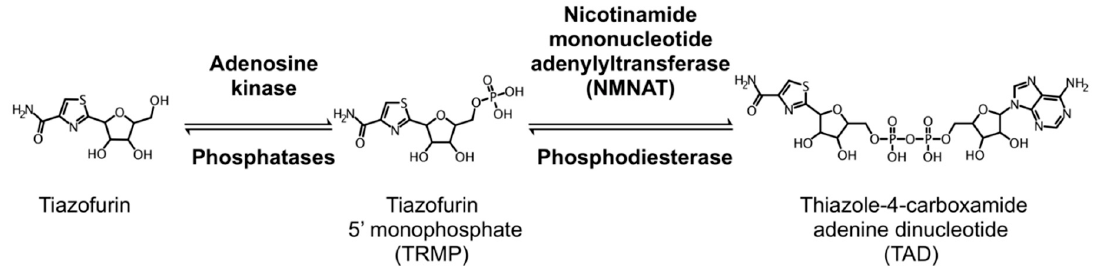
Figure 5. Intracellular metabolism of tiazofurin. Tiazofurin is a prodrug that is metabolized intracellularly in two steps to its active form TAD. TAD is an NAD analogue that inhibits IMPDH.